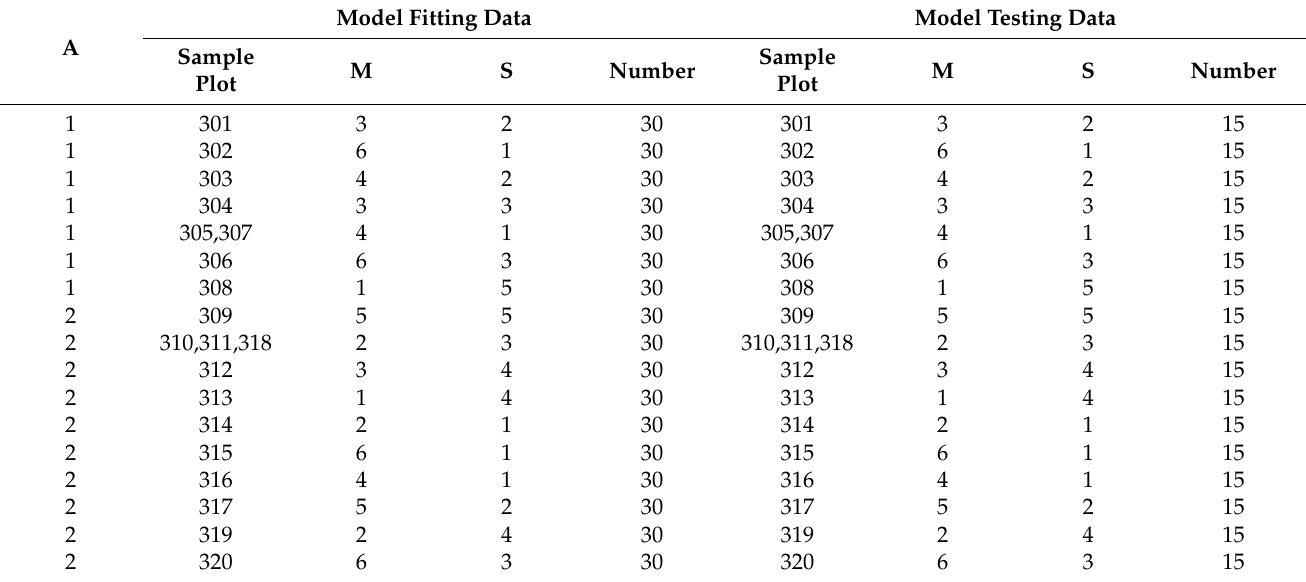
Table 1. A total of 765 Larix olgensis trees in 20 PSPs with 14 types of M ∗ S and 2 altitude levels. Number of Larix olgensis trees (Numbers), stand density class (M), and site index class (S) of each sample plot in model fitting data and model testing data can be seen in this table. (Note: A = altitude of the sample plot; A = 1 when the altitude of the sample plot is higher than 700 m; A = 2 when the altitude of the sample plot is less than 700 m. M = stand density class of the sample plot; S = stand index class of the sample plot. The ranges of M and S are shown in Table 3).